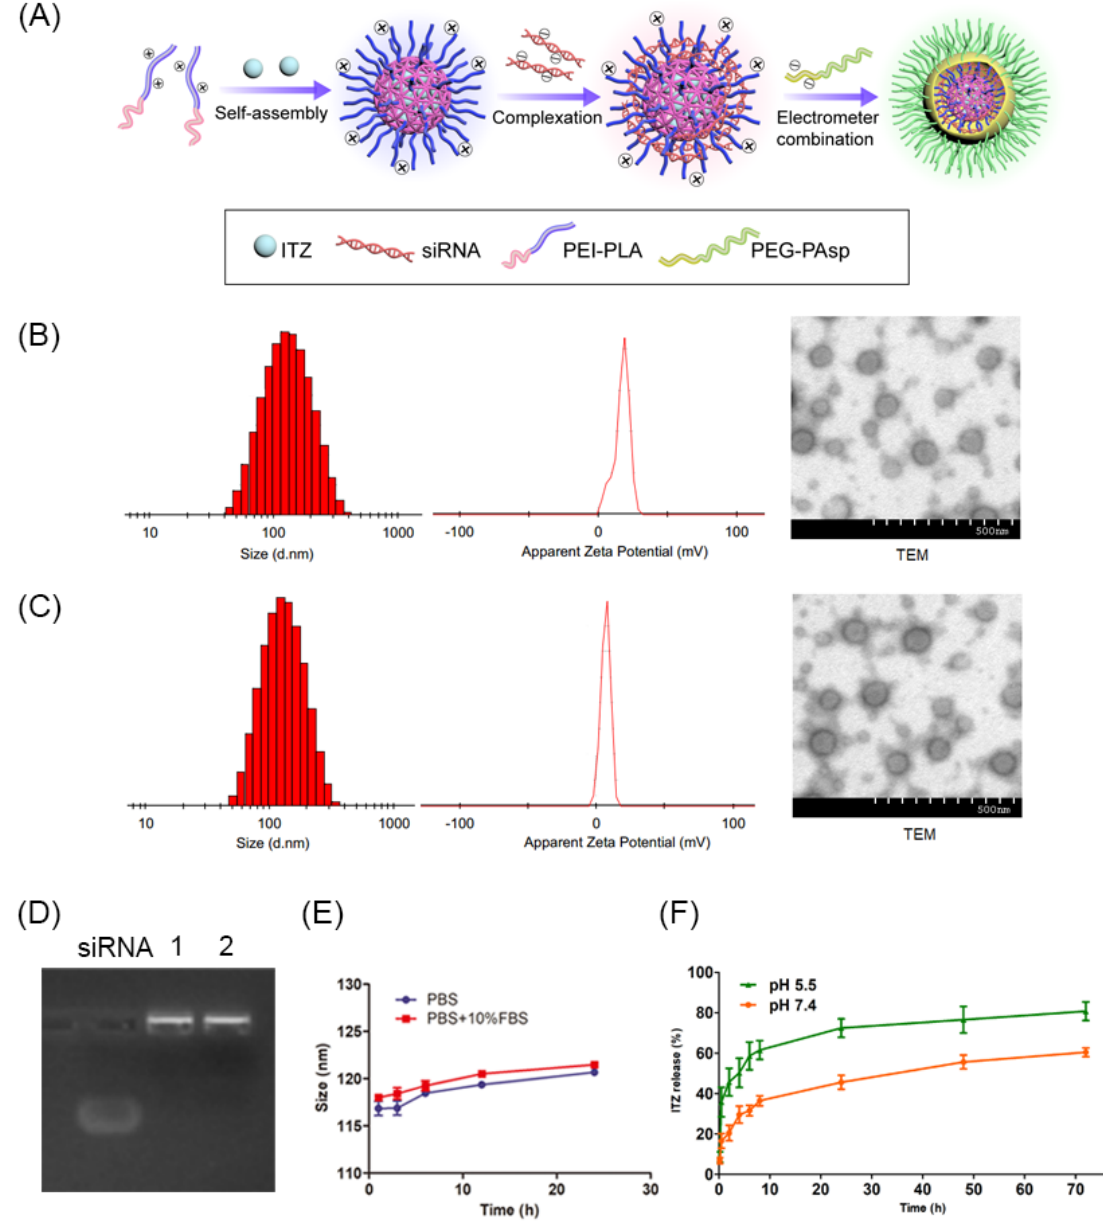
Figure 3. ( A ) ITZ/siRNA-loaded layer-by-layer nanoparticle delivery system. Particle size, zeta potential and TEM of Blank NPs ( B ) and ITZ-siRNA VEGF NPs ( C ). ( D ) Gel electrophoresis assay. ( E ) Time-dependent colloidal stability of ITZ-siRNA VEGF NPs. ( F ) Cumulative in vitro release profiles of ITZ-siRNA VEGF NPs in PBS release medium at pH 5.5 and pH 7.4, respectively. Data plots and error bars represent the mean ± SD ( n = 3), (N/P = 30, C/N = 1/5 and ITZ content of 8.28%).